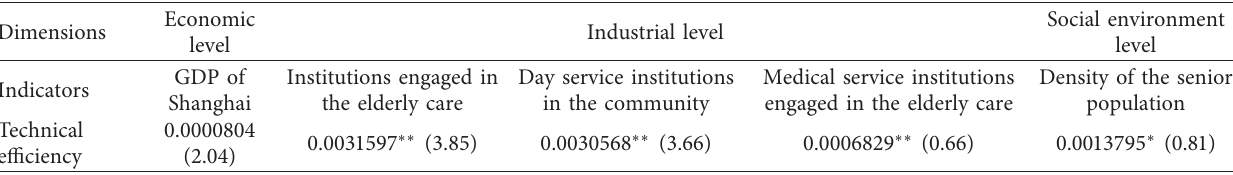
Table 6: Analysis of factors influencing the efficiency of pension resources